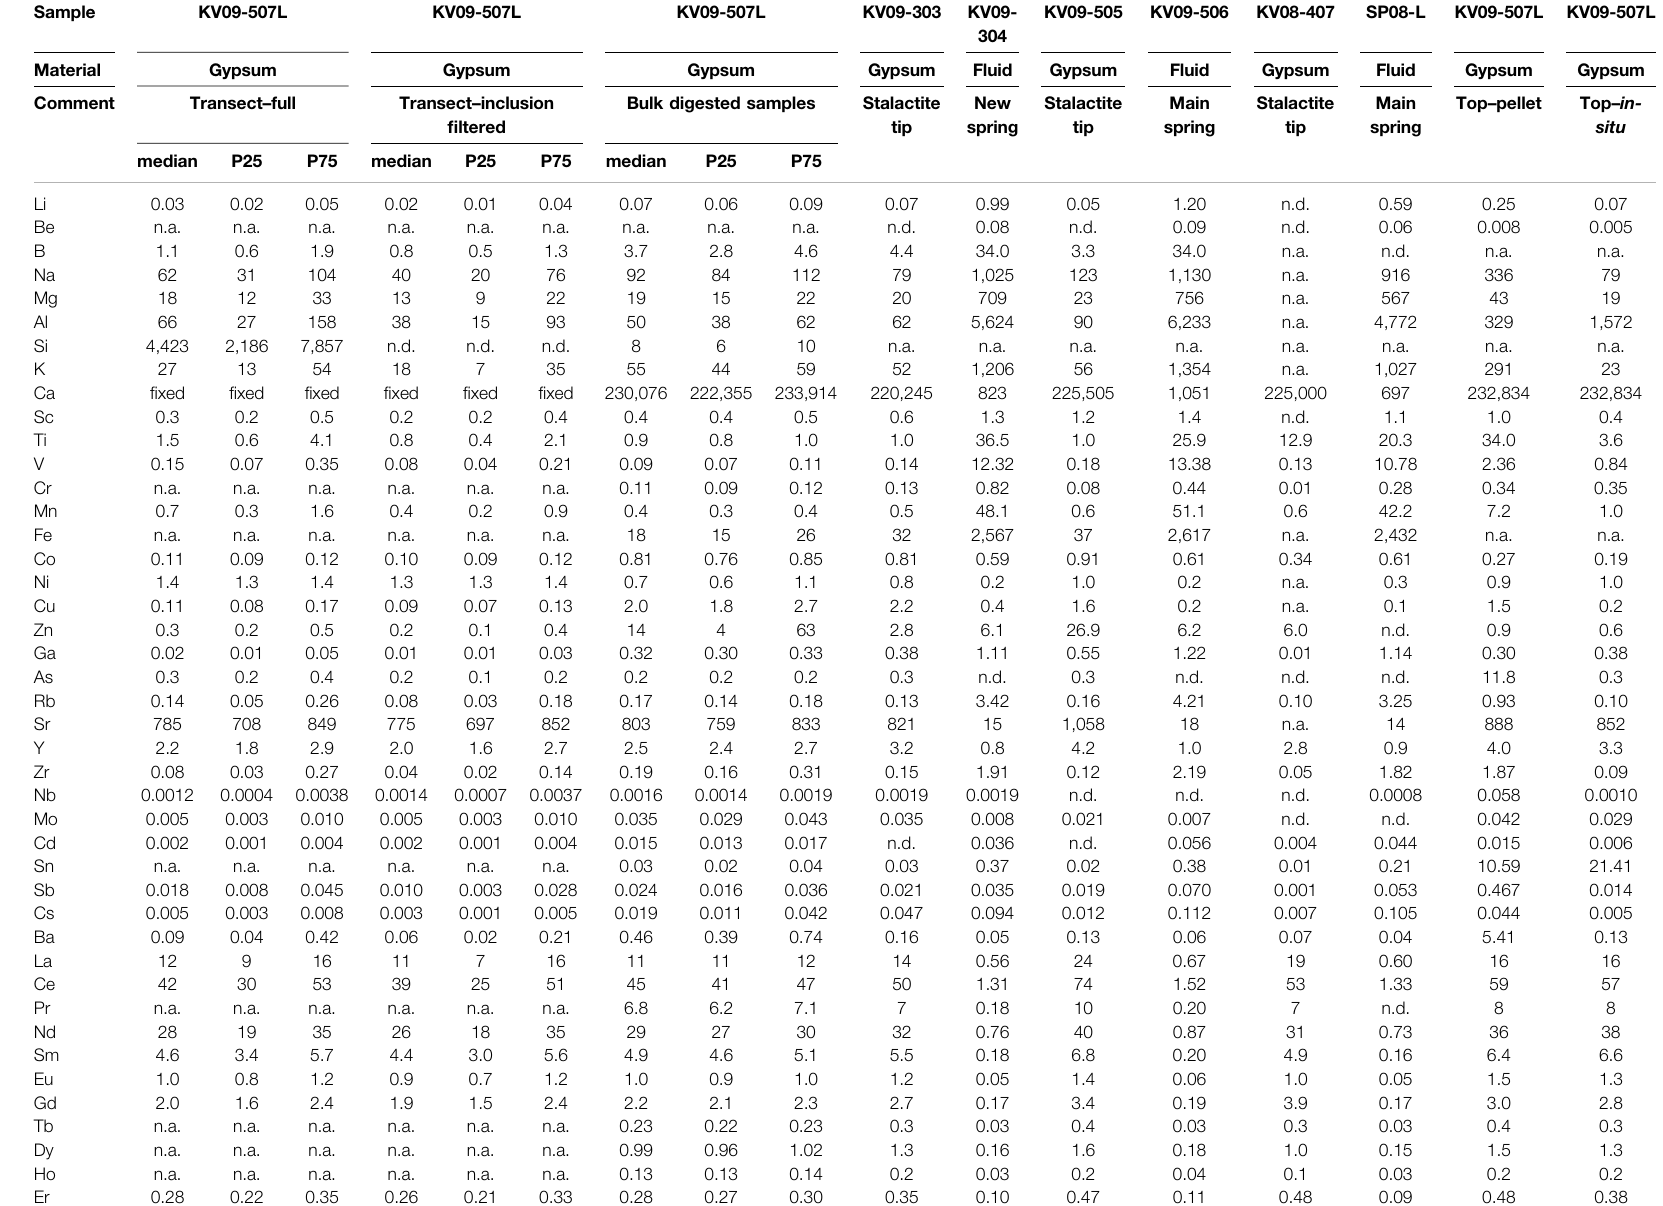
TABLE 1 | Compositions of gypsum and fl uid